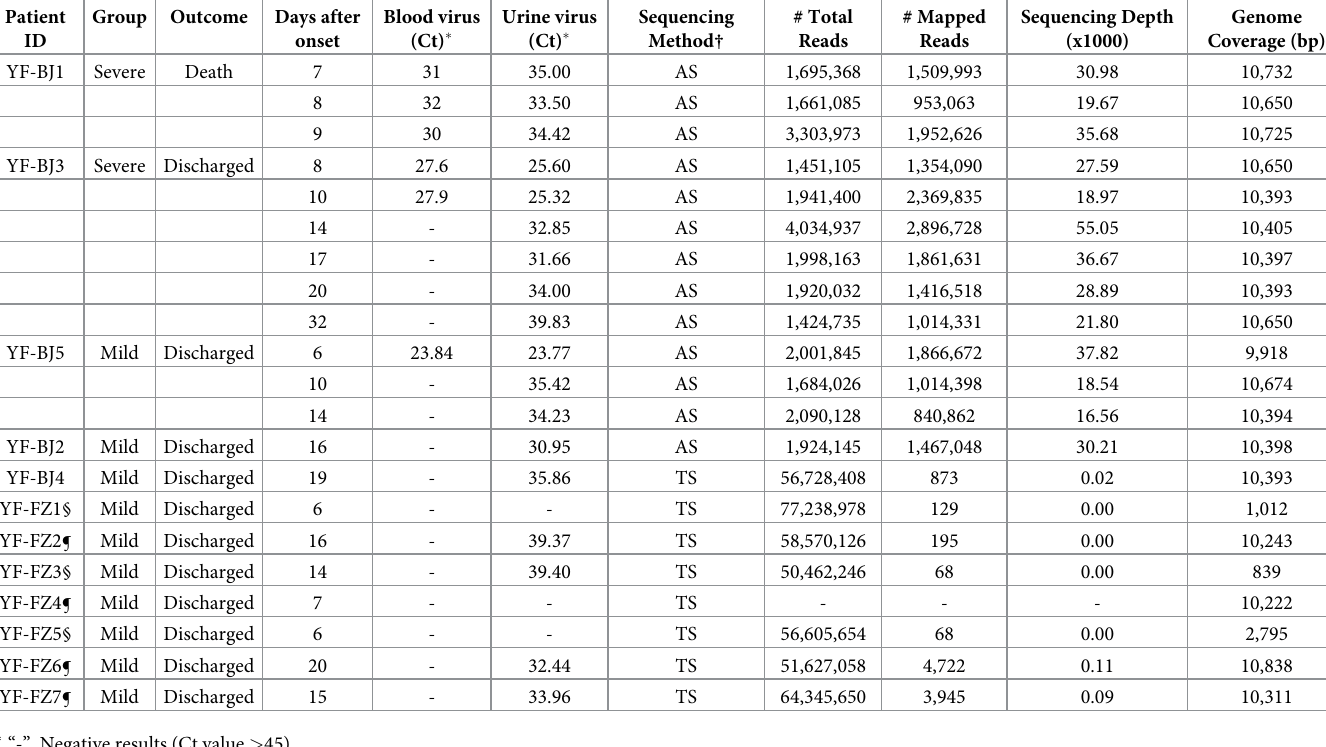
Table 1. Patient information, viral loads and genome sequencing in urine